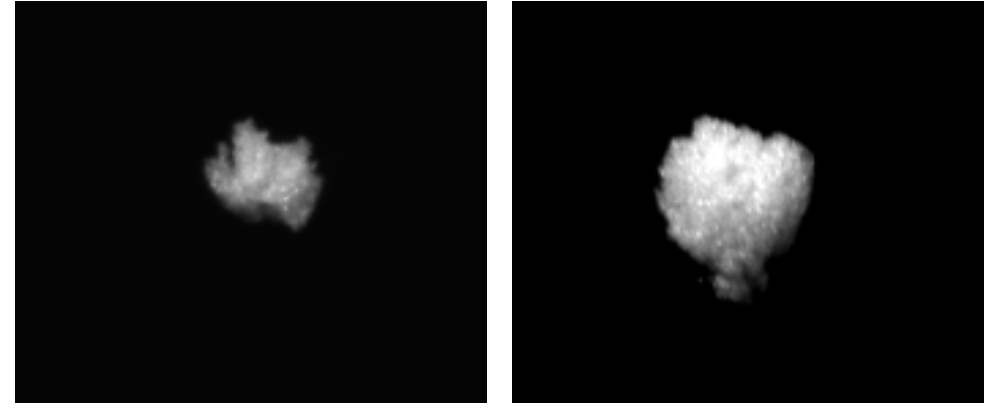
Figure 21. Example MASC images recorded during the 16 February 2015 graupel showers at the MASCRAD Easton site.